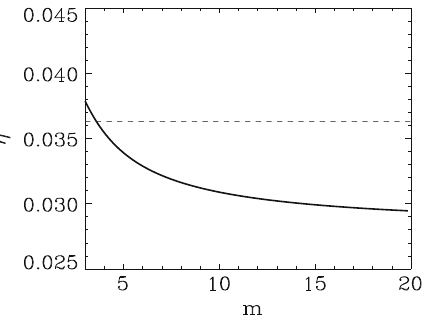
Fig. 1 The anomalous dimension η for the regulator considered (type- A) in this work as a function of the proper-time parameter m . In the m = ∞ limit we find η = 0 . 0294. The dashed line indicates η = 0 . 03629 obtained with conformal bootstrap method which is the most accurate determination nowadays